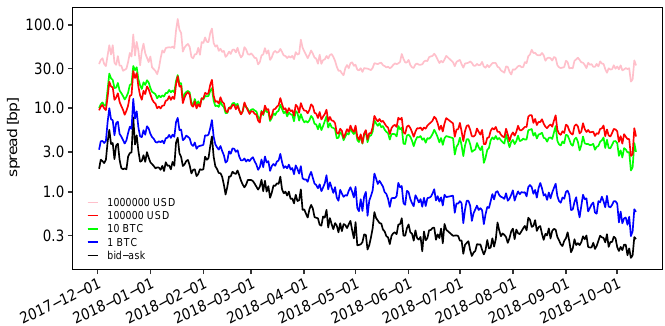
Figure 6. Evolution of daily average liquidity costs. The figure displays the evolution of the daily averages of the bid-ask spread ˜ s ( t ) and the volume-weighted average price spread ˜ vs ( ω , t ) for different volumes ω